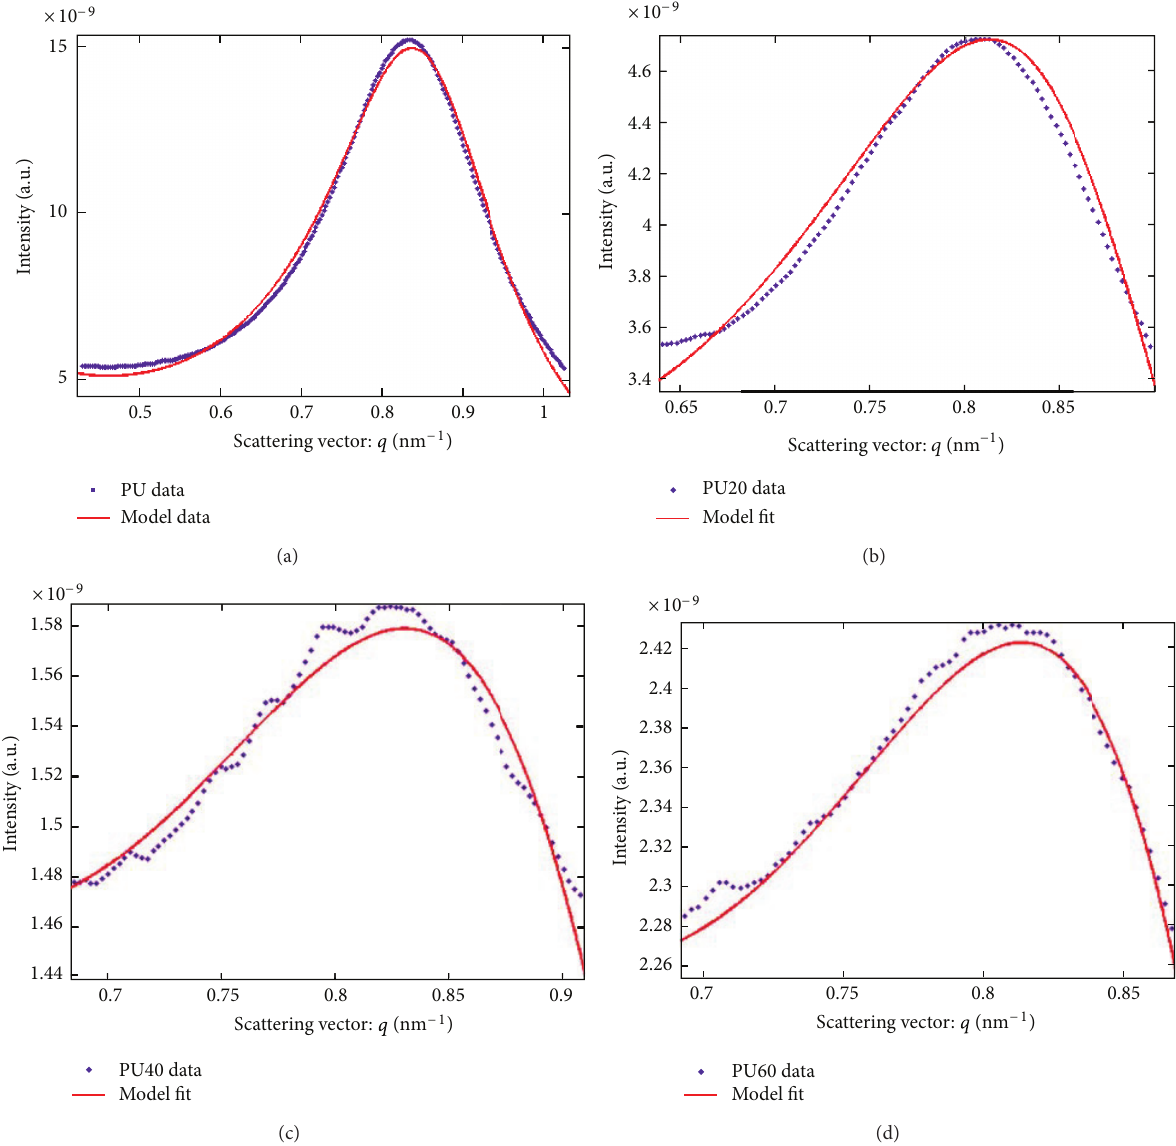
F 4: Curve �tting according to the �ernike-�rins model for �� composites loaded with (a) �, (b) 2�, (c) 4� and (d) ��wt.